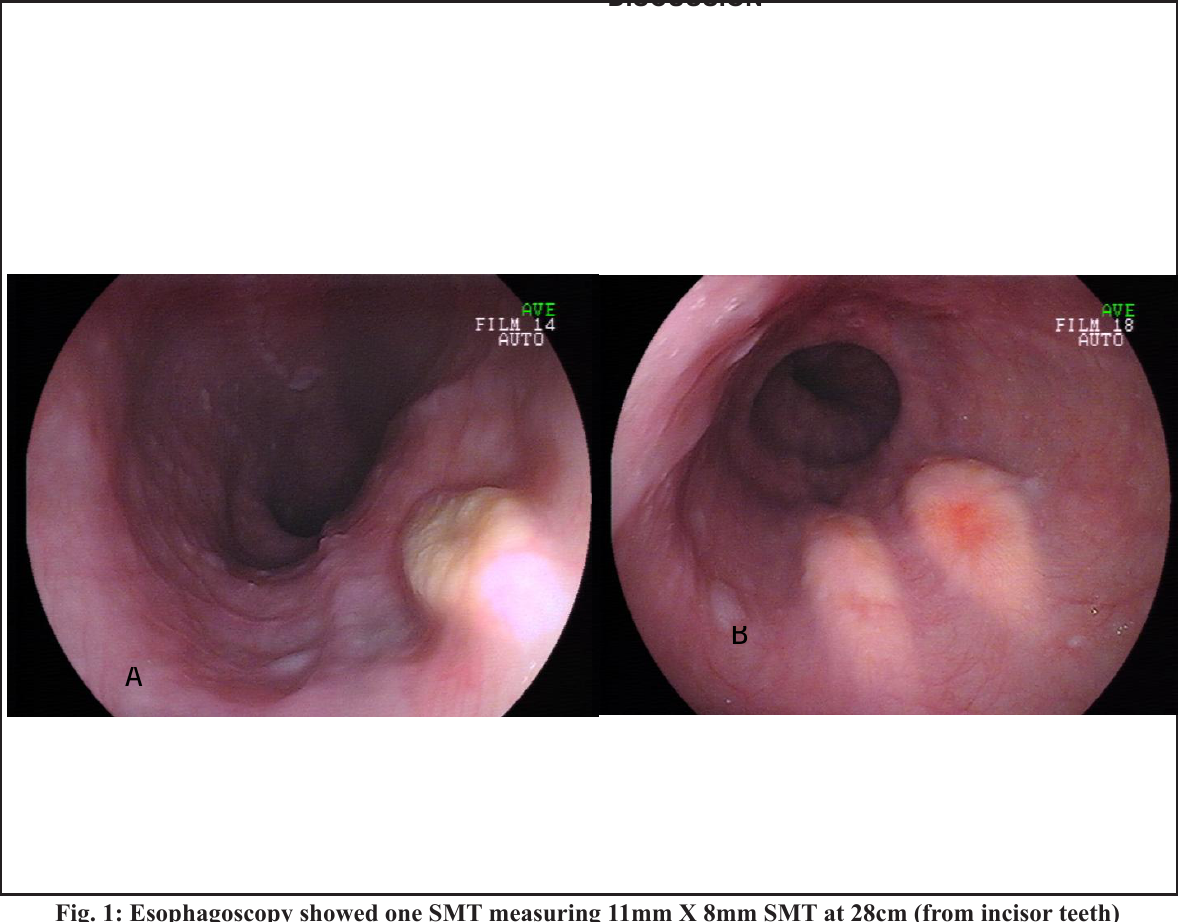
Fig. 1: Esophagoscopy showed one SMT measuring 11mm X 8mm SMT at 28cm (from incisor teeth) (A) and two SMTs measuring 13mm X 8mm and 12mm X 6mm at 35cm of the esophagus. (B) All the SMTs were yellowish in color with umblication at the surface with intact